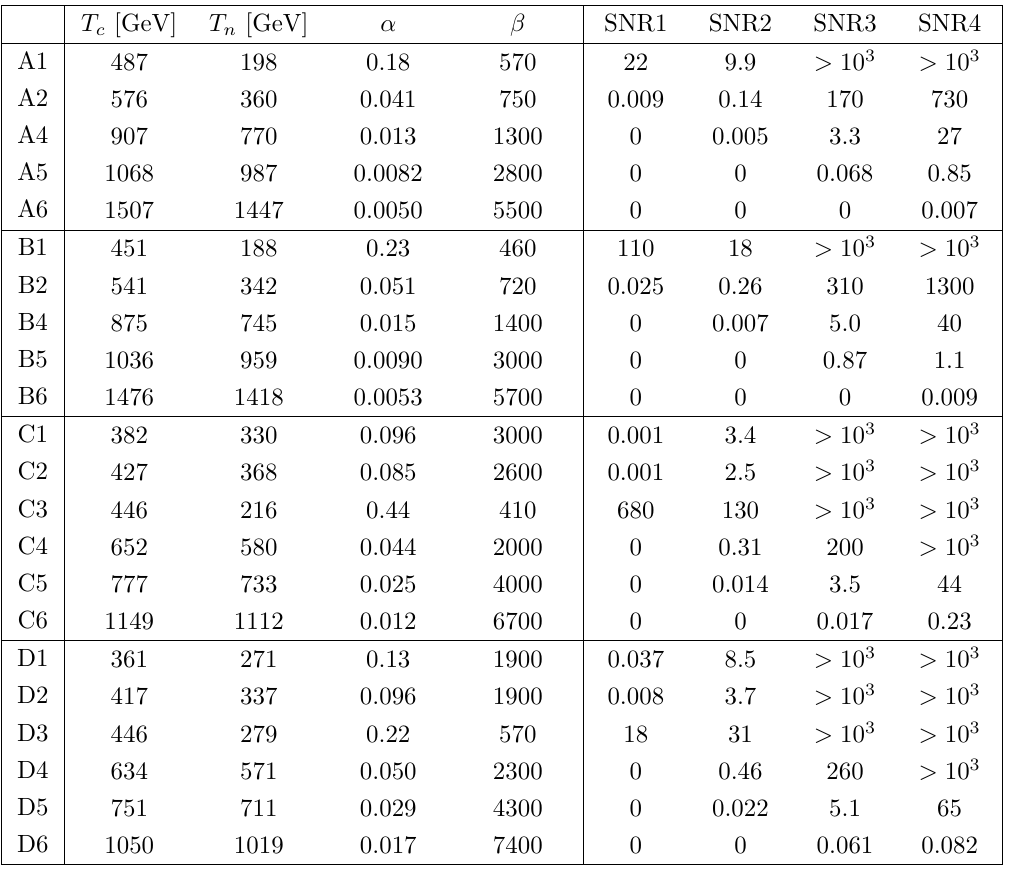
Table 4 . Phase transition parameters at the benchmark points and corresponding signal-to-noise A3 and B3 do not provide a phase transition and are thus